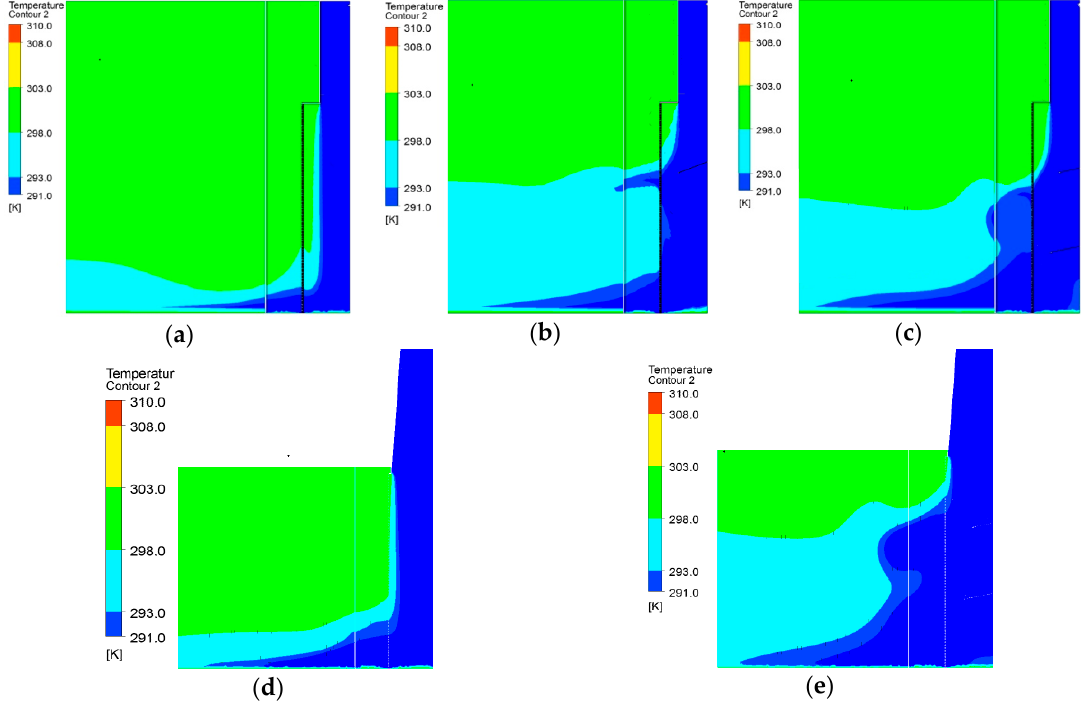
Figure 5. Temperature distribution in the premises with the air distribution system.